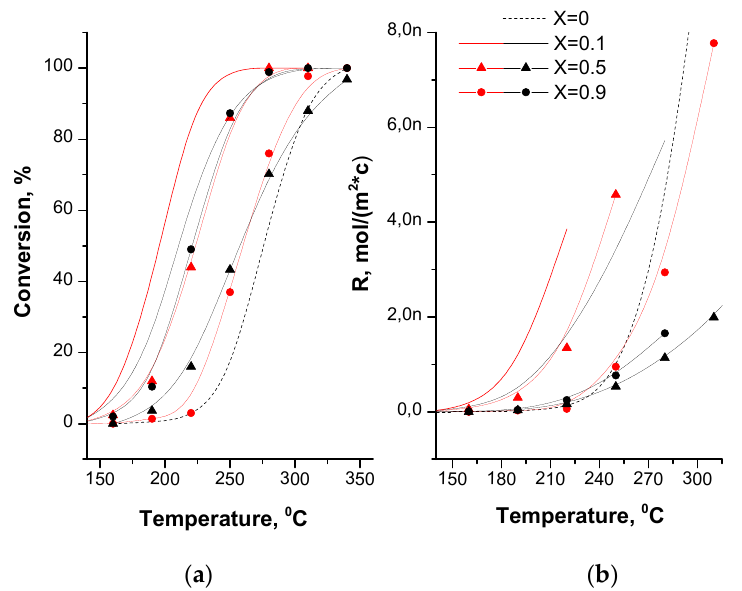
Figure 4. Temperature dependence of ( a ) conversion and ( b ) reaction rate of N 2 O decomposition for Cs/Mg-Co (black) and Cs/Ni-Co (red) samples.